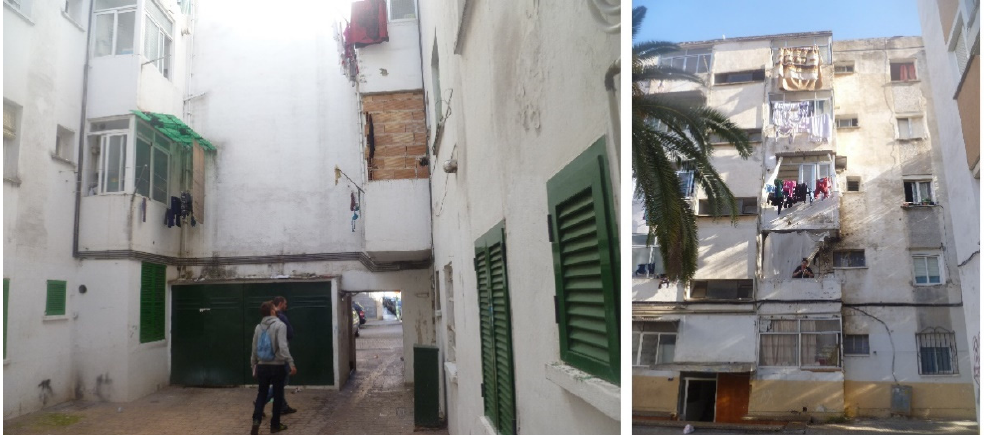
Figure 8. 1960s social housing development: neglected communal areas and inner courtyards, home with shuttered windows to deter squatters. Source: Prepared by the author (22 January 2021).